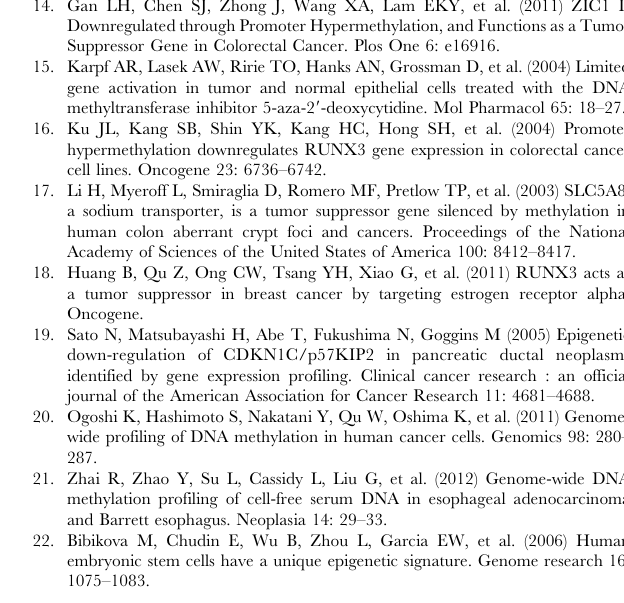
Table S1 Downregulated transcripts in tumor com- pared to normal epithelial cells. In tumorous epithelia, 2533 downregulated transcripts were identified which belong to 1509 known genes. Table S2 Putative methylation regulated transcripts in LCM CRC samples. 154 common elements of 2533 down- regulated transcripts in LCM tumor samples and 3000 upregu- lated transcripts from 5-Aza-treated HT29 cells. Table S3 Putative methylation regulated transcripts downregulated in both adenoma and CRC samples. From the 154 methylation related transcripts (listed in Supple- mentary Table S2.), 108 were also downregulated in adenoma samples. These transcripts were found to be inactivated by DNA methylation at the early phase of carcinogenesis. Supplemetary Figure S1 shows the expression pattern of these genes in normal, adenoma and tumor samples. Table S4 Applied primer sequences. The table shows the primer sequences used for RT-PCR validation of mRNA levels of six genes (top) and for bisulphite sequencing on PTGDR